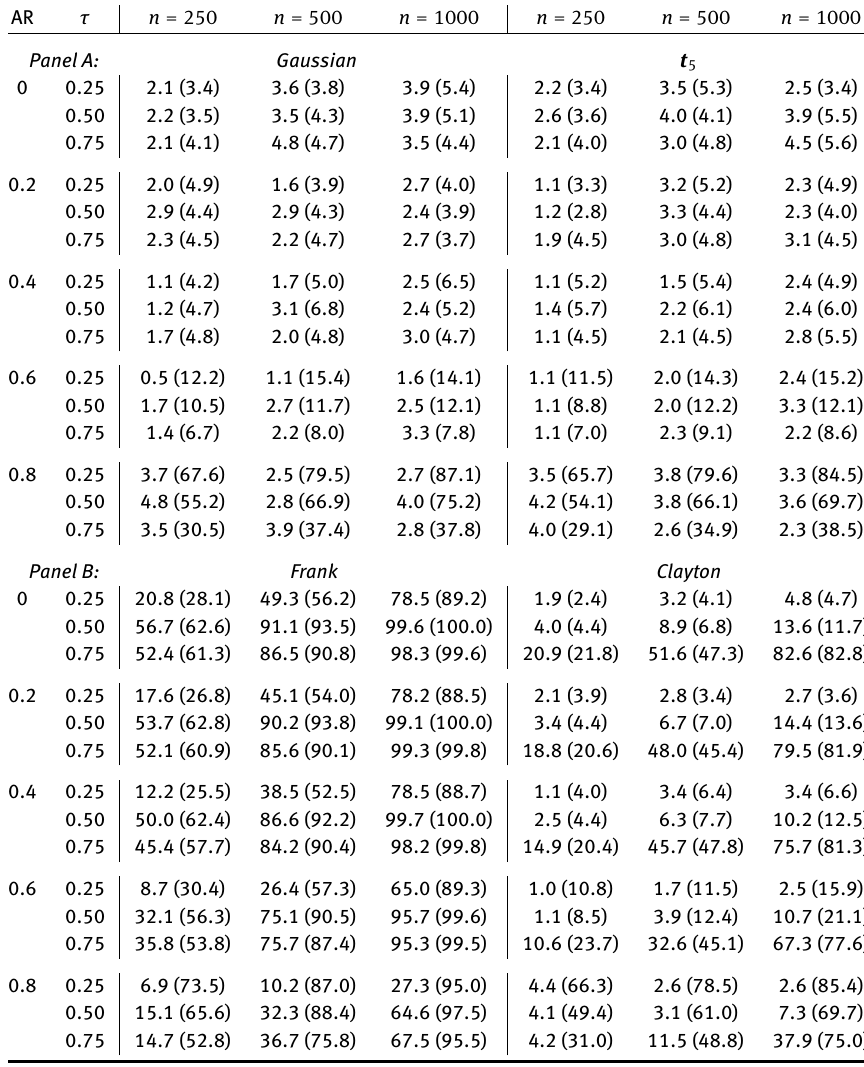
Table 3: Analogue of Table 1 in dimension d = 6